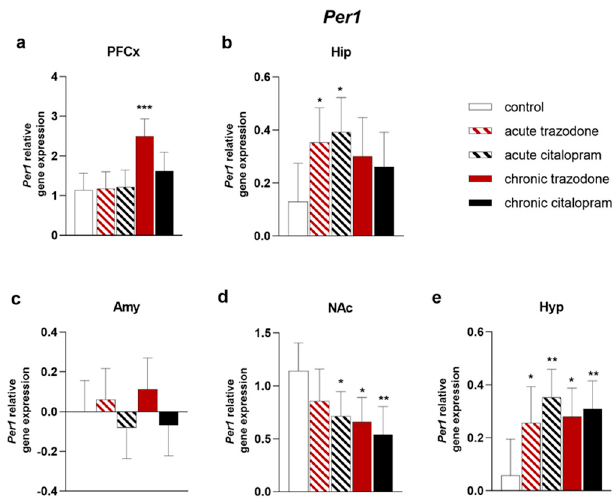
Figure 8. mRNA levels of Per1 in the PFCx ( a ), Hip ( b ), Amy ( c ), NAc ( d ), and Hyp ( e ) after acute or chronic treatment with trazodone, citalopram, or vehicle. The least square predicted means with 95% confidence intervals are plotted. Data were log-transformed when required to stabilise the variance and satisfy the parametric assumptions ( c ). ***: p < 0.001; **: p < 0.01; *: p < 0.05 in the Planned Comparison vs. control. n = 6/group.